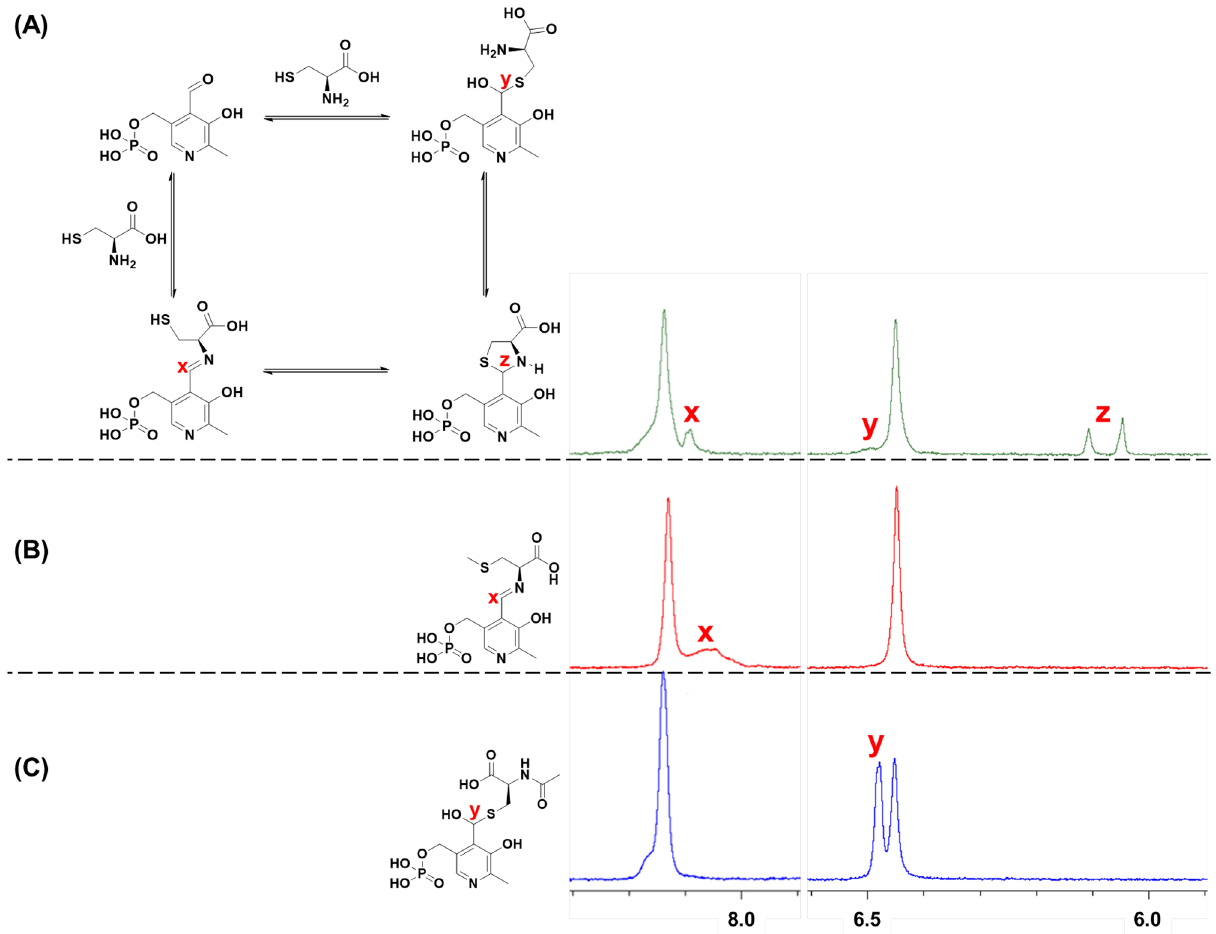
Figure 2. 1 H-NMR zoomed spectrum of 1:1 molar reaction mixture of PLP and (A) cysteine, (B) S -methylcysteine (SMC), and (C) N -acetylcysteine (NAC) in D 2 O reacted at 37 °C for 2 h. Schiff base is formed with the reaction of PLP and SMC. The aldiminic proton of a Schiff base is observed at δ ≈ 8 ppm. Hemimercaptal is formed with the reaction of PLP and NAC. The enolic proton of the hemimercaptal is observed at δ ≈ 6.5 ppm. Presence of Schiff base, hemimercaptal, and thiazolidine ring (δ = 6.05, 6.10 ppm) is observed with reaction of PLP and